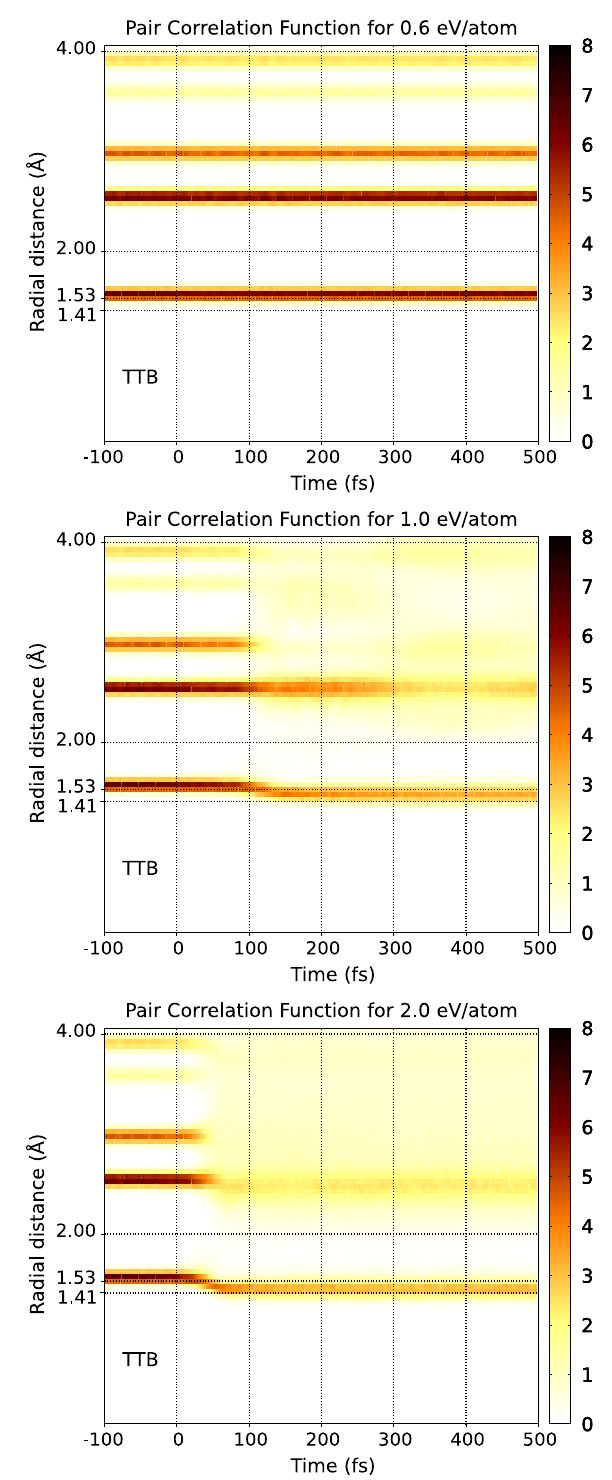
Figure 2. Temporal evolution of pair correlation function for various X-ray absorbed doses: (top) 0.6 eV/atom, (center) 1.0 eV/atom, and (bottom) 2.0 eV/atom in diamond bulk as predicted by XTANT . Pulse parameters are the same as in Ref. 10 : XUV photon energy of 47.4 eV, pulse duration 52.5 fs FWHM. The calculations were performed with a 512-atom supercell. The figure has been generated using gnuplot 5.0 patchlevel 6 (http:// gnupl ot.